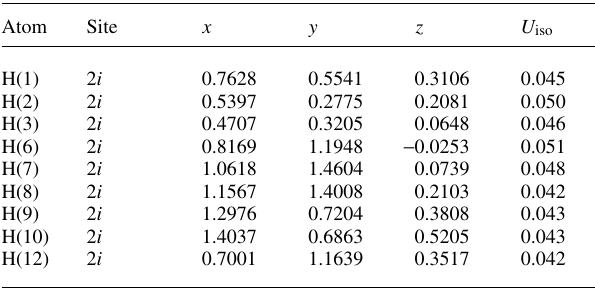
Table 2. Atomic coordinates and displacement parameters (in Å 2 )